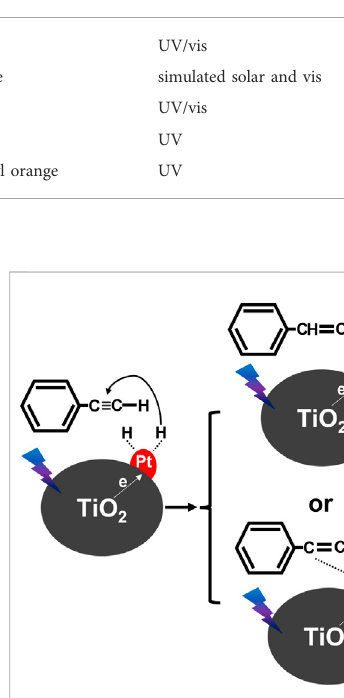
TABLE 3 Exemplary results for the optimization of platinum content. Tested Content of Pt